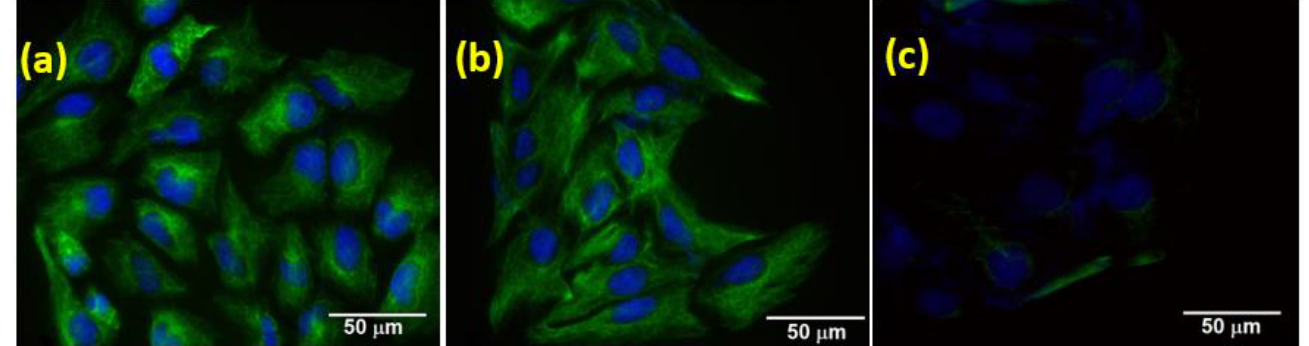
Figure 7. Effect of GR-HAP on EMT. The SUM-159 cells were treated with ( a ) GR, ( b ) HAP, and ( c ) GR-HAP, and vimentin expression was examined using immunofluorescence. Magnification 40X, scale bar: 50 μm.